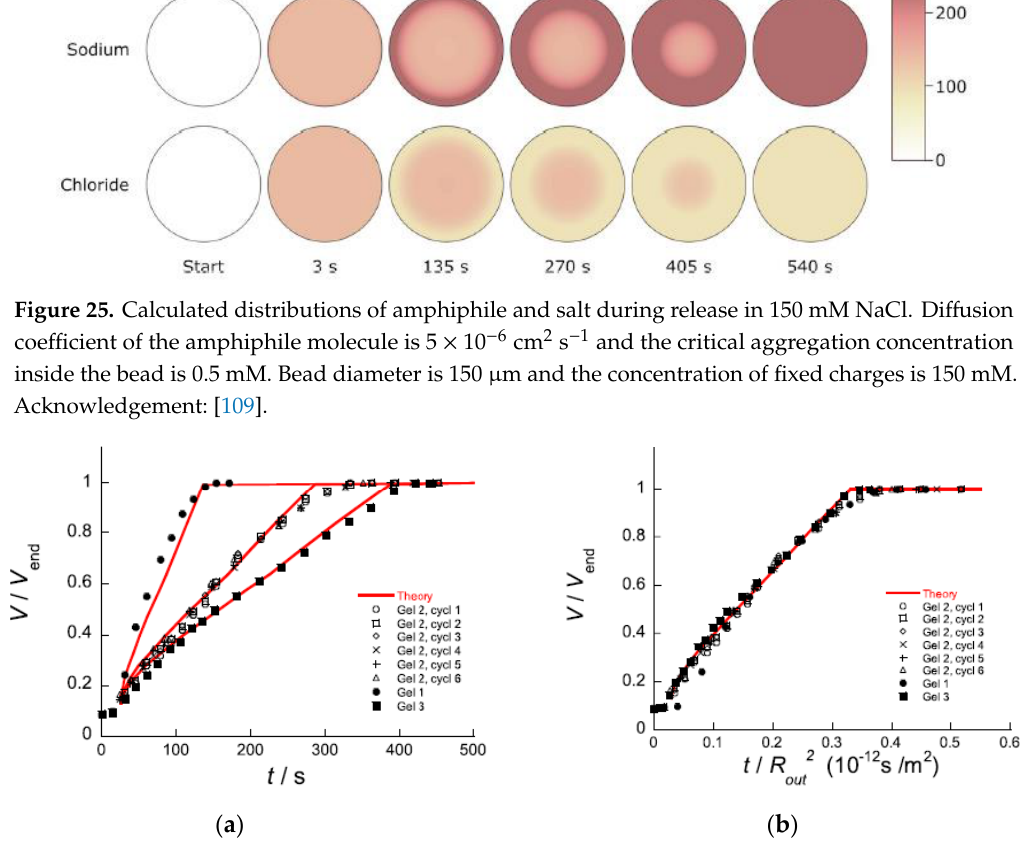
Figure 27. Theoretically calculated fraction of released AMT from a single microgel as a function of time (solid curve). Shown for comparison is the calculated relative gel volume for the same gel (dotted) and the calculated fraction released from a gel with constant radius (dashed). Figure taken from ref. [69]. Used with permission. 6. Conclusions Our review shows that the research field has progressed slowly but steadily since the previous review appeared in the year 2006. Several fundamental aspects pertaining to the nature of the volume transition induced by proteins and amphiphilic substances in polyelectrolyte gels have been clarified. Increasing charge of the binding species and network chains as well as decreasing ionic strength and crosslinking density, have been found to increase the tendency of gels to undergo discontinuous phase transition and to favor the core–shell mechanism over bulk instability transition. Theoretical model calculations of inhomogeneous gels, in equilibrium or in quasi-static equilibrium states, have provided detailed insight into the phase transition mechanisms and how the systems are expected to develop under various environmental conditions. In particular, net attraction between proteins or micelles in the gel has been found to be a requirement for core–shell phase coexistence, and it has been suggested that the electrostatic interactions, mediated by the polyion chains in the networks, can be solely responsible for that, but for amphiphilic molecules the hydrophobic driving force also contributes. The result highlights the importance of distinguishing between the driving force for phase separation and the driving force for binding to the gels. For (non-hydrophobic) macroions, the entropy of releasing network counterions is a major motive for binding but not for phase separation;